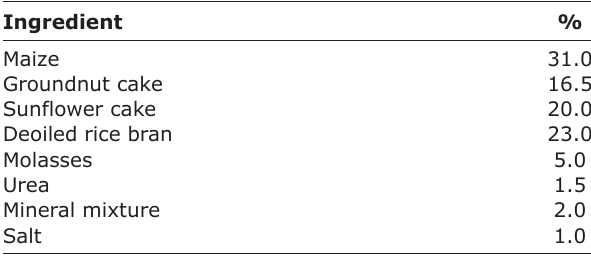
Table-1: Ingredient composition of the concentrate mixture. Ingredient